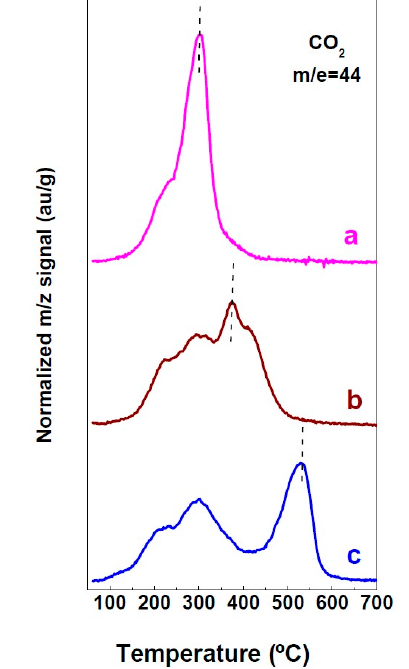
Figure 4. MS CO 2 traces corresponding to decomposition of W3 hydroxycarbonate precursor mixed with different amount of NaNO 3 ( a ) +5.0 wt% NaNO 3 ( − ) ( b ) +1.8 wt% NaNO 3 ( − ), ( c ) as original, no NaNO 3 added ( − ).